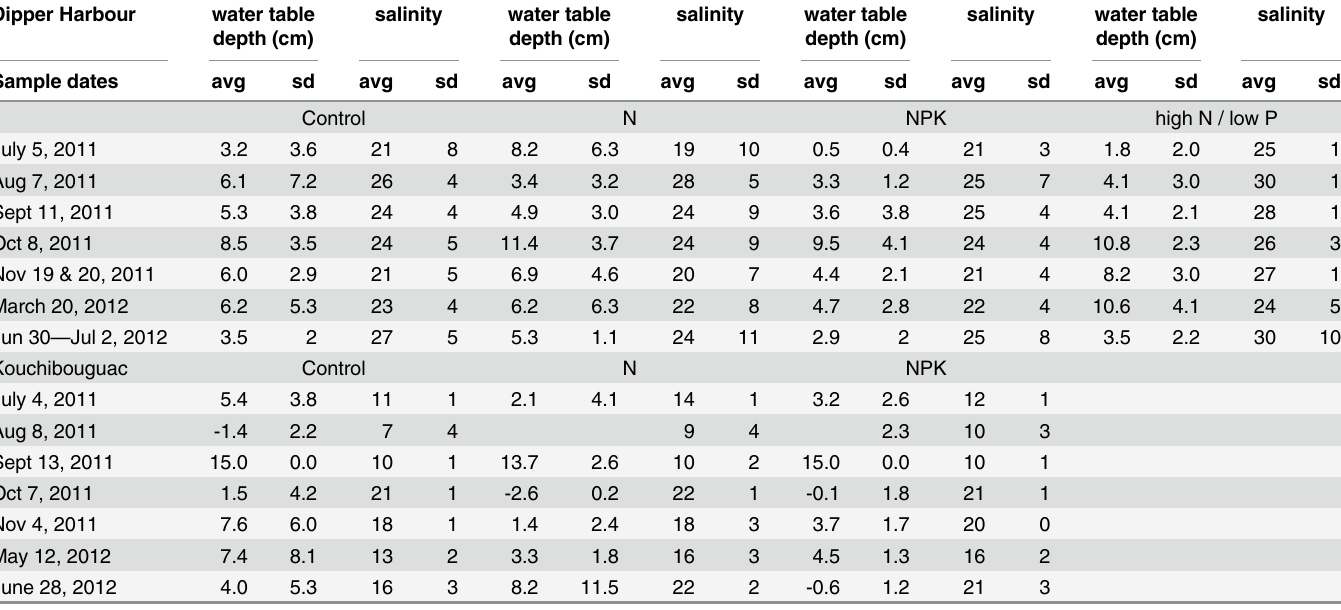
Table 2. Average (avg) and standard deviation (sd) of water table depth and salinity by treatment and sample event at Dipper Harbour and Kouchi- bouguac salt marshes. In April soil porewater was frozen, thus no measurements were